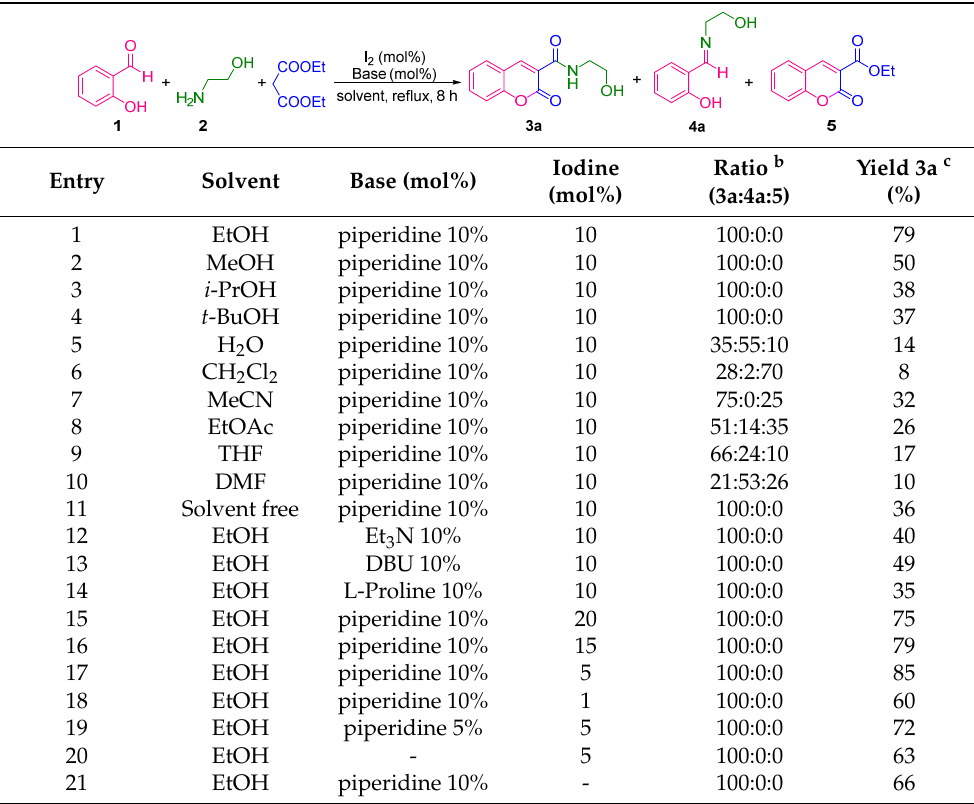
Table 1. Optimization of the reaction conditions a .